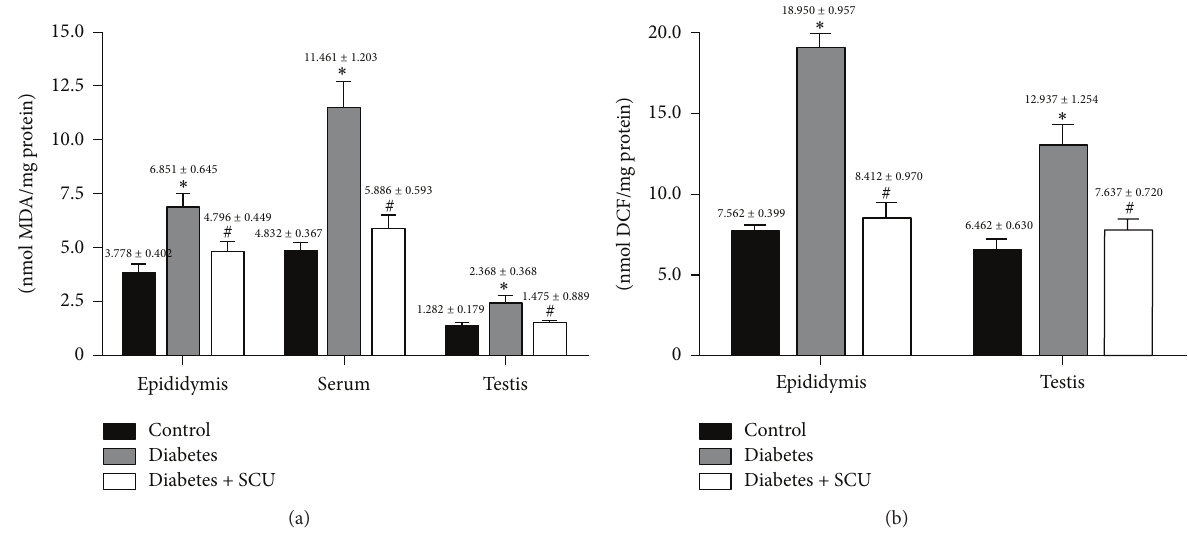
Figure 2: Oxidative stress measured as the concentration of MDA and ROS. MDA was measured to determine lipid peroxidation levels of testes, epididymis, and serum (a) and fluorescent product DCF was measured to determine ROS levels of testes and epididymis (b). Data in (a) and (b) are presented as means ± SEM ( 𝑛 = 8) ; ∗ 𝑃 ≤ 0.05 , compared to control group; # 𝑃 ≤ 0.05 , compared to diabetes group.